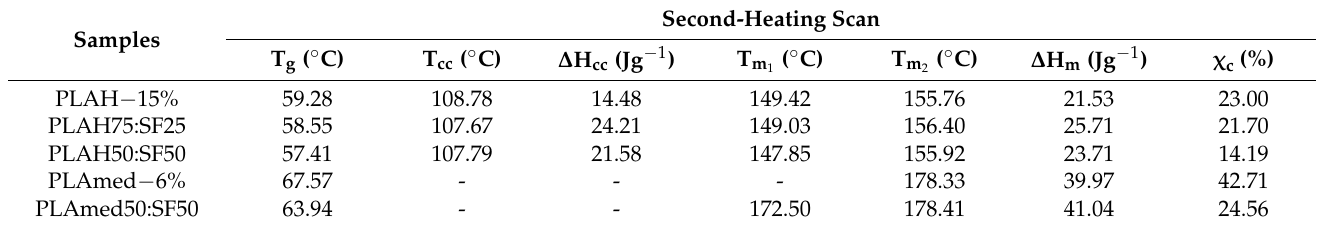
Table 7. Thermal properties of PLAH − 15, PLAH75:SF25, PLAH50:SF50, PLAmed − 6, and PLAmed50:SF50 obtained from DSC thermogram during second-heating scan.